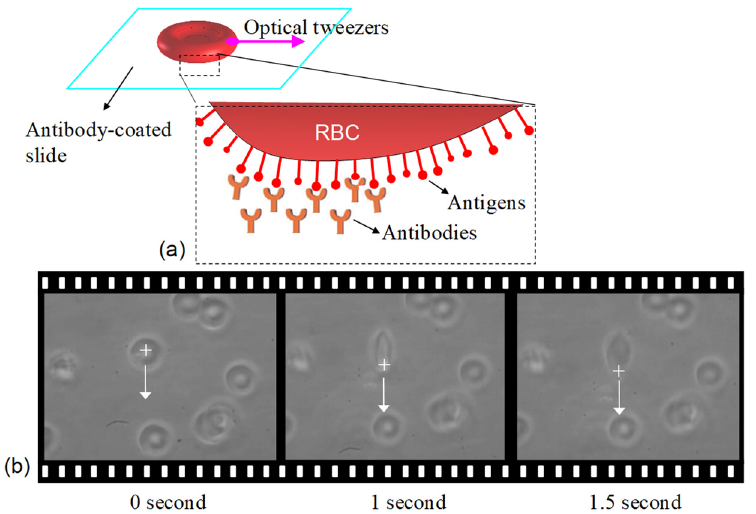
Figure 2. ( a – c ) schematic illustration and ( d ) the manipulation films (Video S1, Supplementary Material) of an RBC.